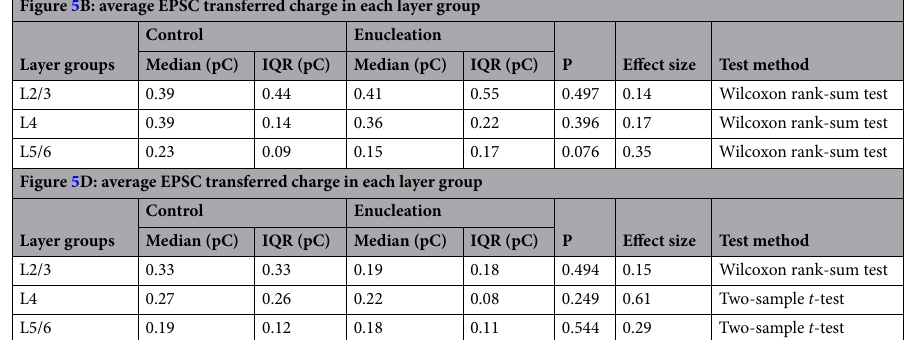
Figure 5B: average EPSC transferred charge in each layer group Layer groups